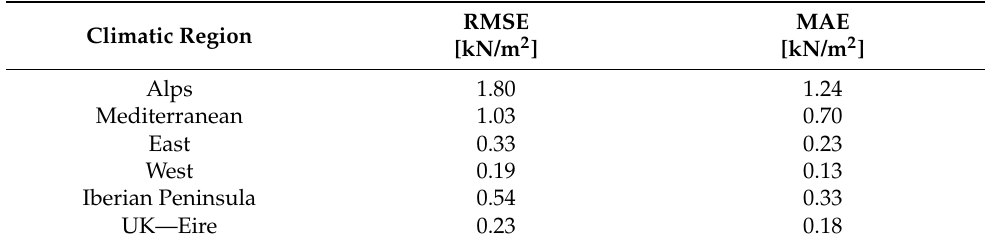
Table 1. Root mean square error (RMSE) and mean absolute error (MAE) statistics derived compar- ing Uncertainties in Ensembles of Regional Re-Analyses (UERRA) and EN1991-1-3 ground snow load maps.